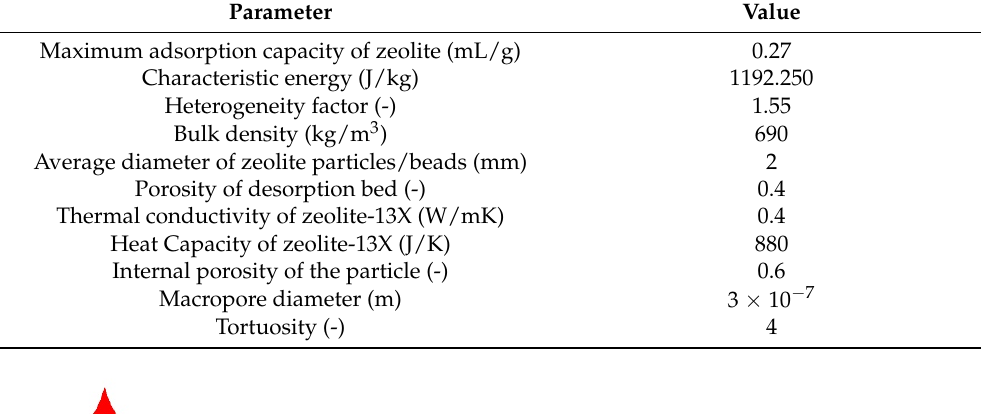
Table 1. Properties of zeolite bed used in the model [22].